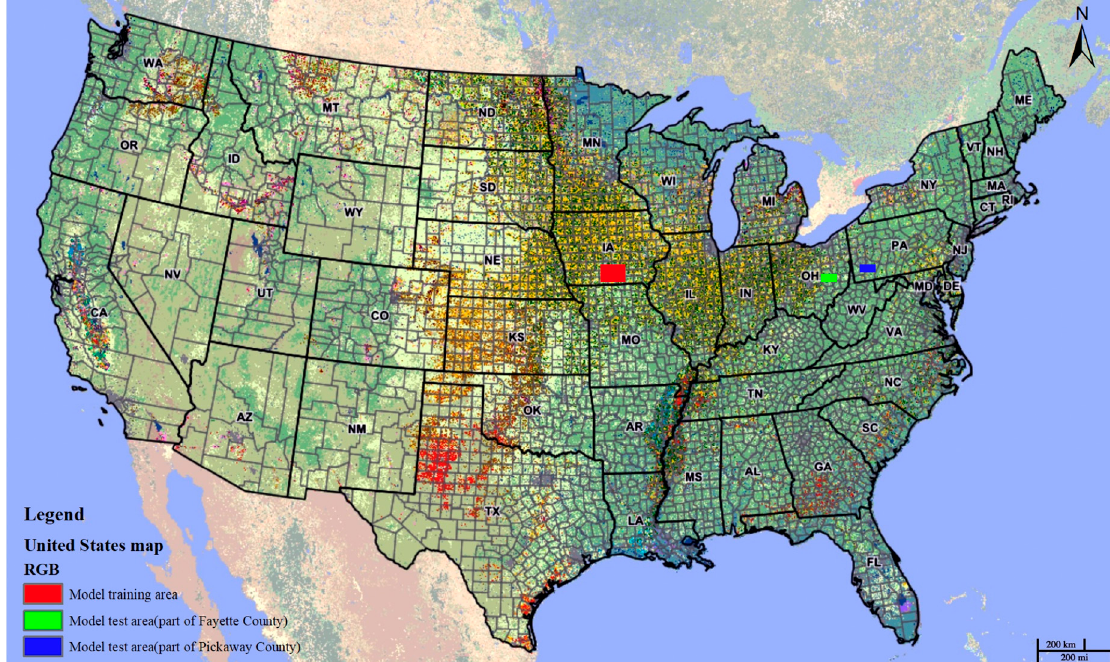
Figure 1. Study areas concentrated in Iowa, Ohio, and Pennsylvania States.